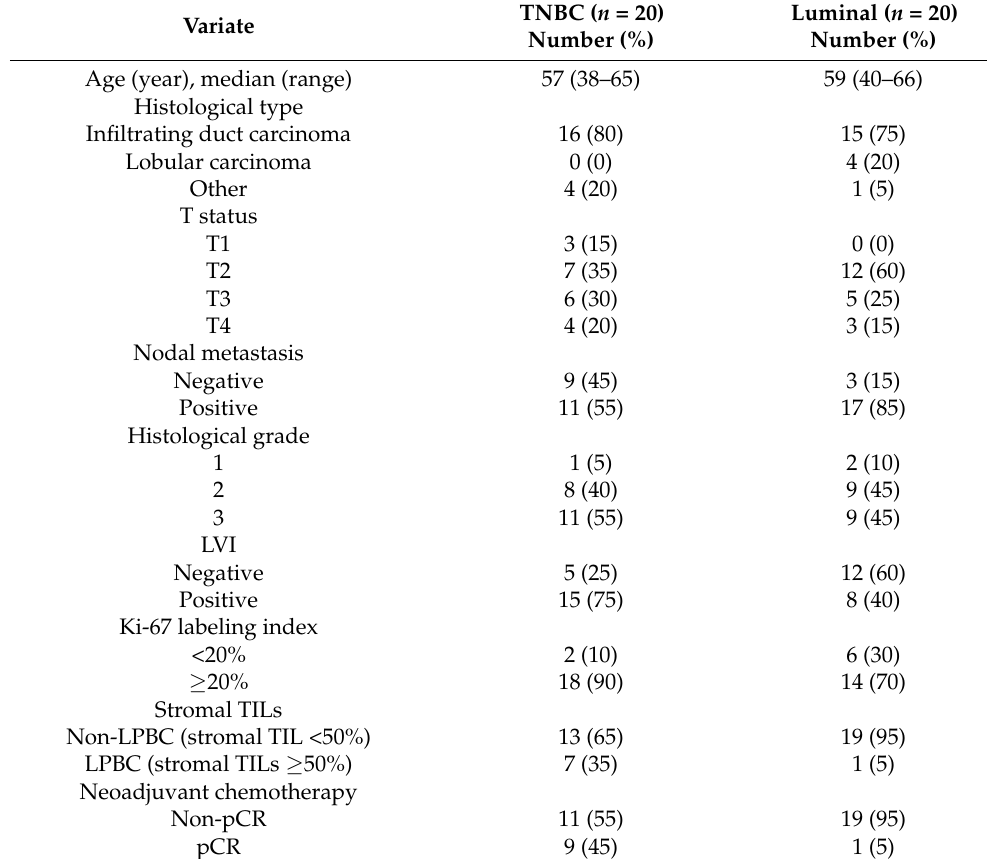
Table 1. Patient characteristics (pre NAC information).